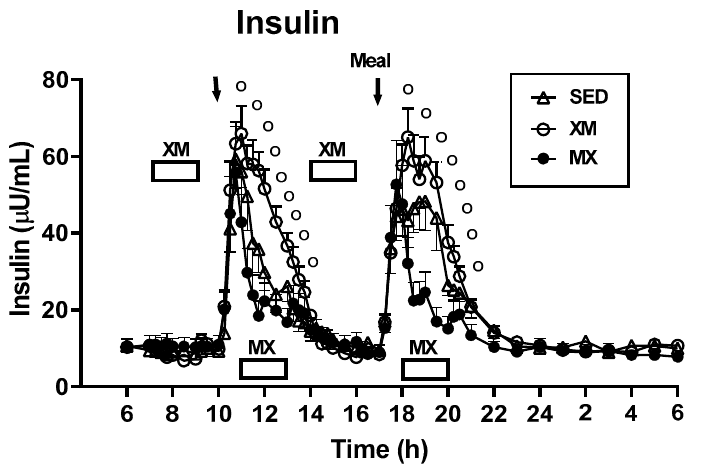
Figure 6. Exercise- and meal-timing effects on insulin concentrations. Circle superscripts identify slices when group differences were significantly different. XM = exercise before meals, MX = exercise after meals, SED = sedentary